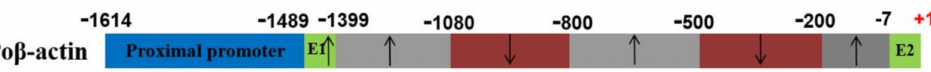
Figure 7. Summary of the Japanese flounder β -actin gene regulatory regions. The regulatory loci identified in this report are designated by ↑ when the gene expression is being enhanced, and ↓ when gene expression is being silenced. The numbers indicate the positions (the first base of starting codon ATG was set as position